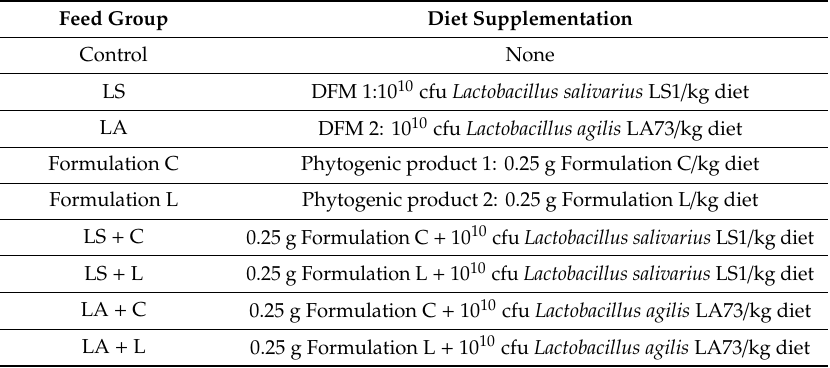
Table 2. Feed additives applied to feed